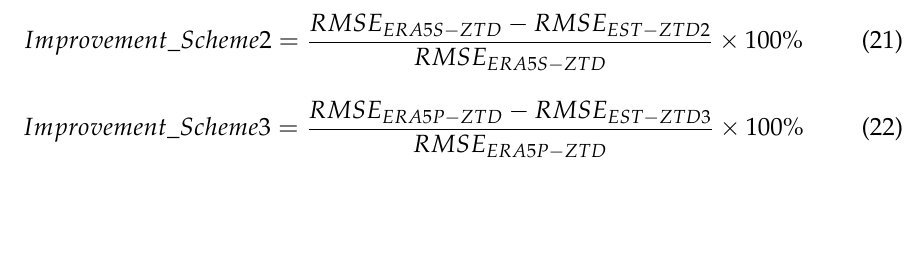
Table 4. Improvement rate of Scheme 2 and 3. Values in brackets refer to the monthly minimal and maximal improvement rate for 10 verifying stations. Unit is percent.